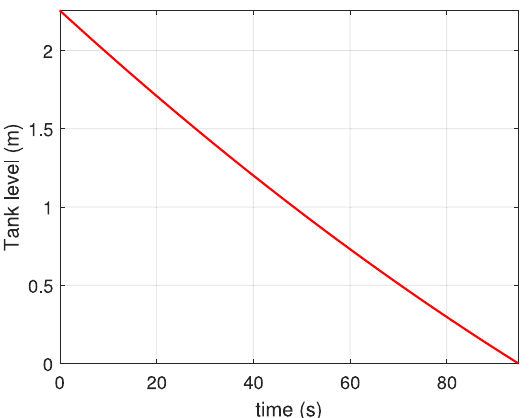
Fig. 5. Molten salt level evolution in time. Initial value H = 2 . 255 m (full cavity).